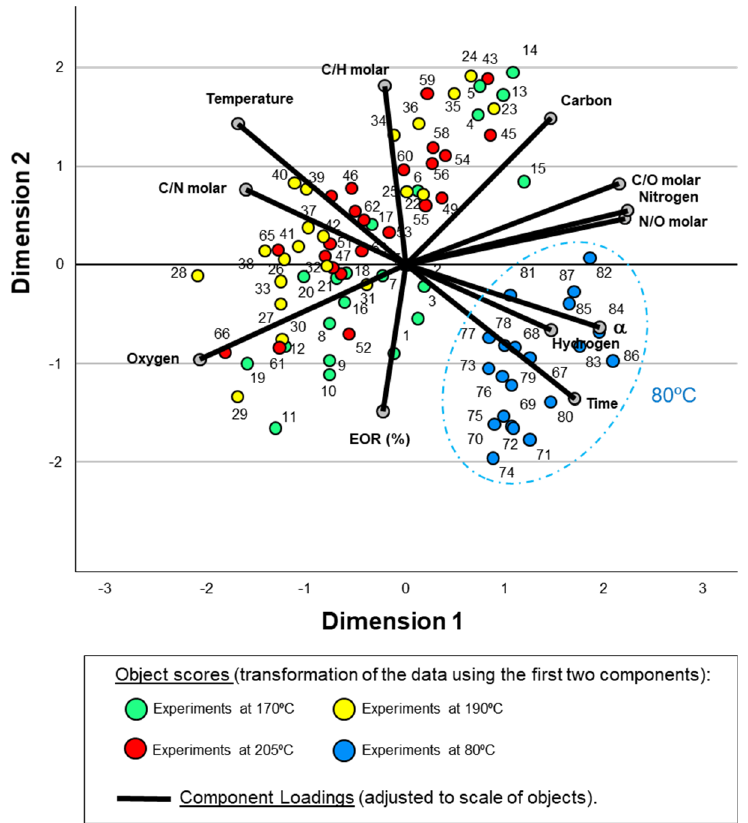
Figure 4. Categorical principal component analysis (CATPCA) biplot using as variables the ex- perimental synthesis conditions used, reaction time and temperature, degree of conversion values, elemental composition data and EOR (%) from the FTIR spectra for the NH 4 CN − derived polymers obtained. A total of eighty seven independent experiments were considered in this study (Table S2). Component loadings of variables are indicated by vectors and object scores of experiments by dots. Green dots represent samples from the 170 ◦ C series, yellow represents the 190 ◦ C series, red repre- sents the 205 ◦ C series and blue represents the 80 ◦ C series. The triplicates considered in this study were the reactions carried out using the experimental conditions detailed in Table S2. The number of experiments corresponds to the reactions in Table S1. The experiments are grouped into two clusters based on the variables: a heterogeneous group and a homogeneous group consisting of the experiments performed at 80 ◦ C (surrounded by an ellipse).